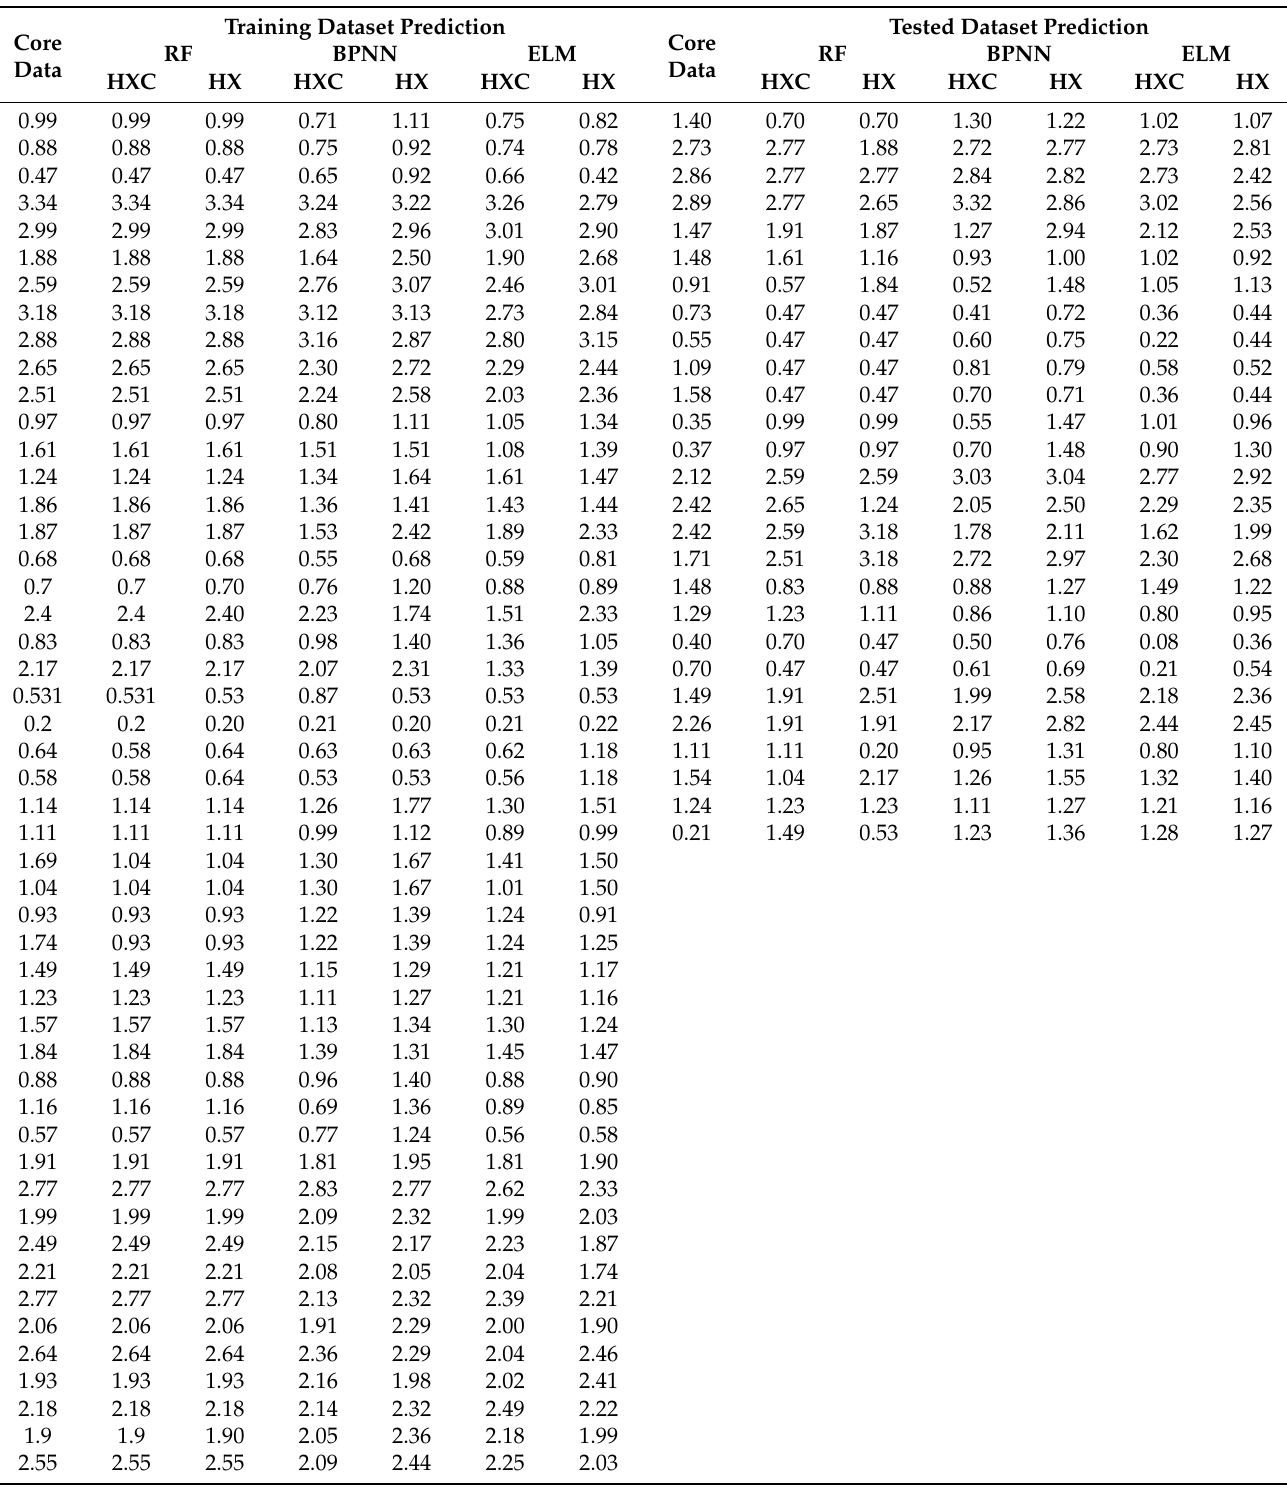
Table 5. Results of TOC prediction from